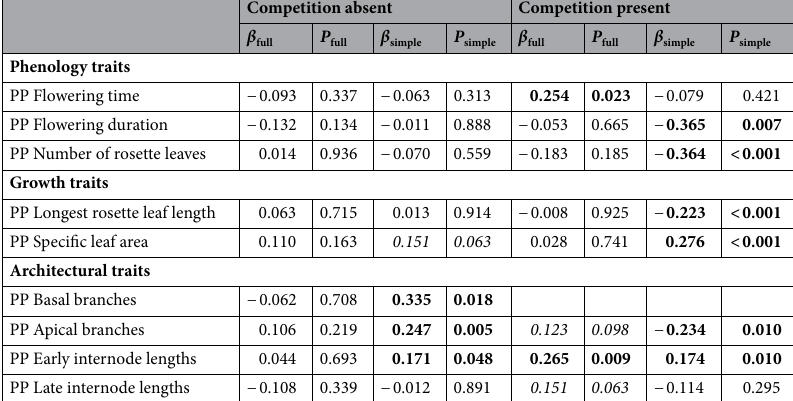
Table 2. Results of selection analyses to estimate the extent to which plasticity is adaptive or maladaptive. Negative values of the coefficient for plasticity ( β ) indicate maladaptive plasticity, while positive values indicate adaptiveness. Significant terms ( P < 0.05) are shown in bold and marginally significant terms (0.05 < P < 0.10) in